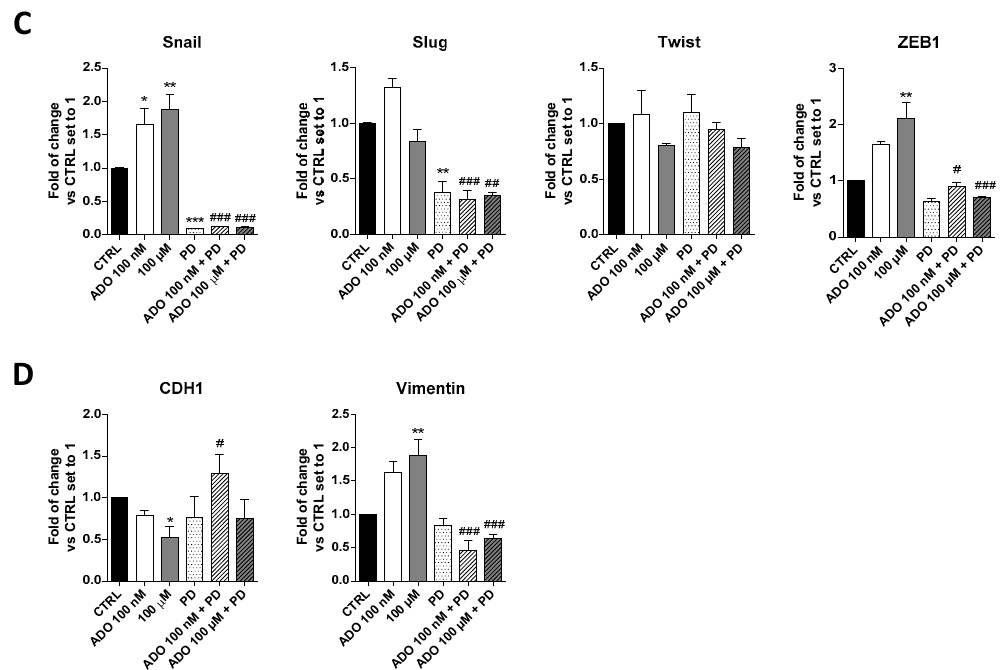
Figure 3. Involvement of ERK 1/2 phosphorylation in ADO-mediated induction of GMT traits. ( A ) Time-course analysis of ERK 1/2 phosphorylation in U343MG cells. U343MG cells were treated with ADO (100 nM and 100 µM) for different time (2 min–72 h), and ERK 1/2 phosphorylation was measured by immuno-enzymatic assay. The data are expressed as the percentage versus untreated cells (CTRL) set to 100% ± SEM of at least three independent experiments performed in duplicate. ( B ) Time-course analysis of total ERK 1/2 in U343MG cells. ( C , D ) U343MG cells were treated with ADO (100 nM and 100 µM) in the presence or absence of 1 µM PD184352 for 72 h. mRNA expression levels of GMT master genes (Slug, Snail, Twist and ZEB1) ( C ) and of the Epithelial (CDH1) and Mesenchymal (Vimentin) markers ( D ) were determined by RT-PCR. The data are expressed as fold changes with respect to basal value set to 1 and are the mean values ± SEM of two independent experiments. The significance of the differences was determined by one-way ANOVA, followed by Bonferroni’s post hoc test or two-way ANOVA with Bonferroni correction and two-sided tests for multiple comparisons. * p < 0.05, ** p < 0.01, *** p < 0.001 vs. CTRL; # p < 0.05, ## p < 0.01, ### p < 0.001 vs. corresponding ADO treatment.